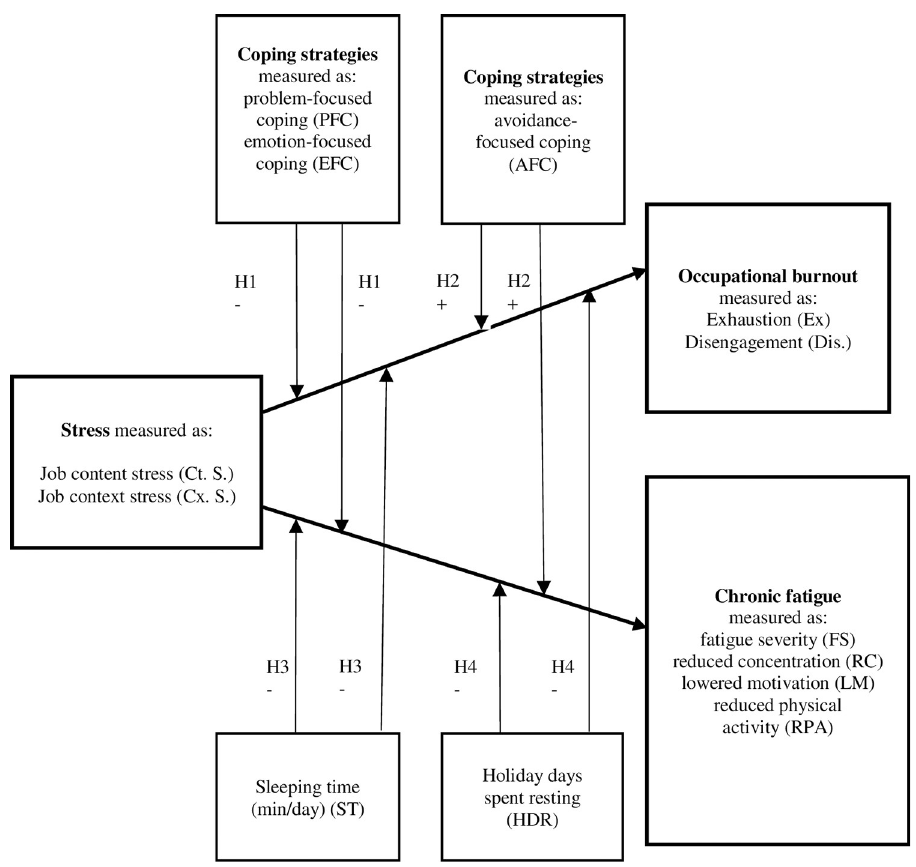
Fig 1. Conceptual model of the moderating role of selected health behaviours on the relationship between stress, occupational burnout, and chronic fatigue.